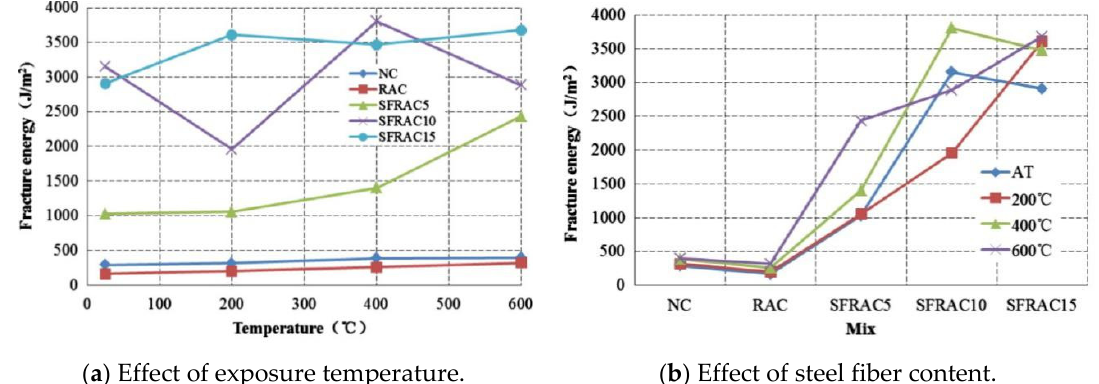
Figure 6. Effects of exposure temperature and steel fiber content on fracture energy [13].